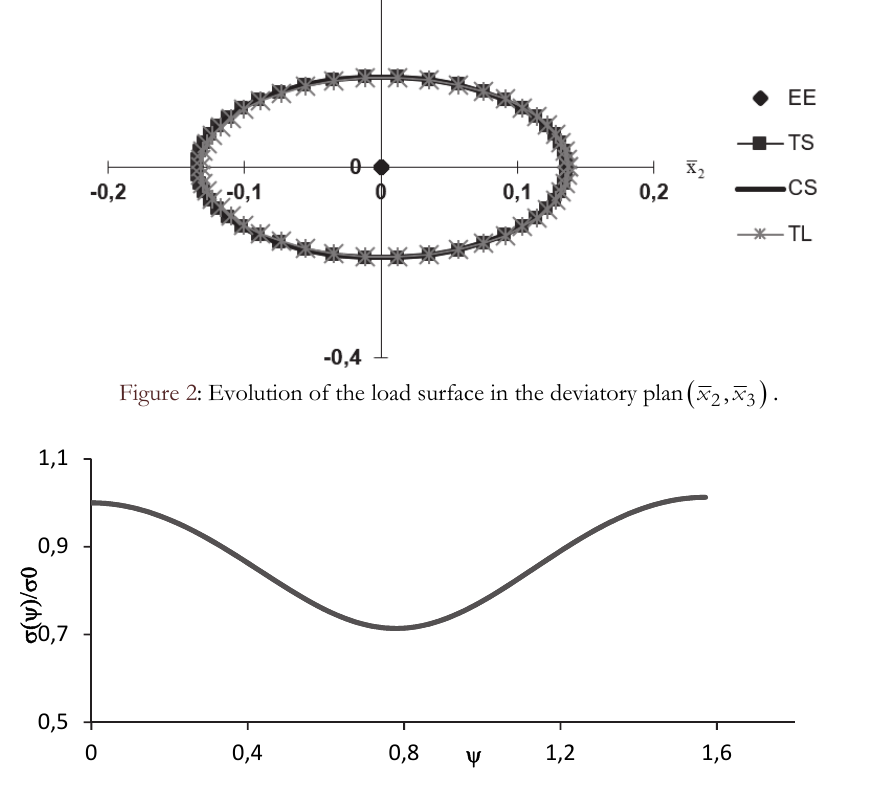
Figure 3: Evolution of the